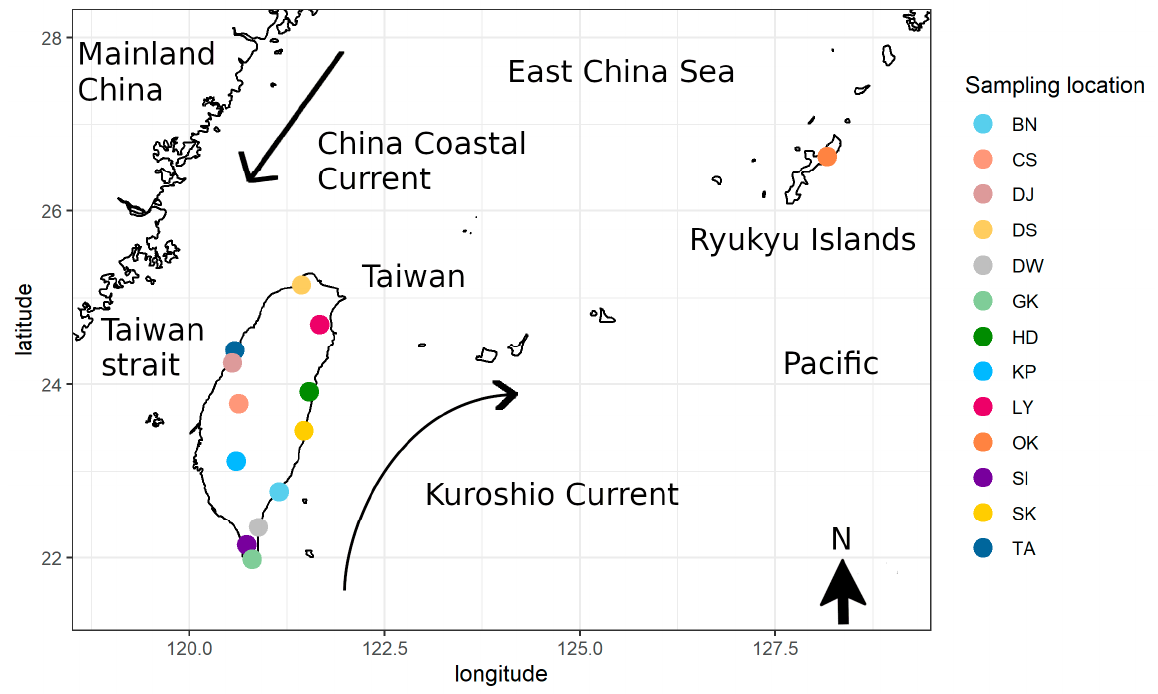
Figure 1. The locations of Macrobrachium japonicum samples in this study.